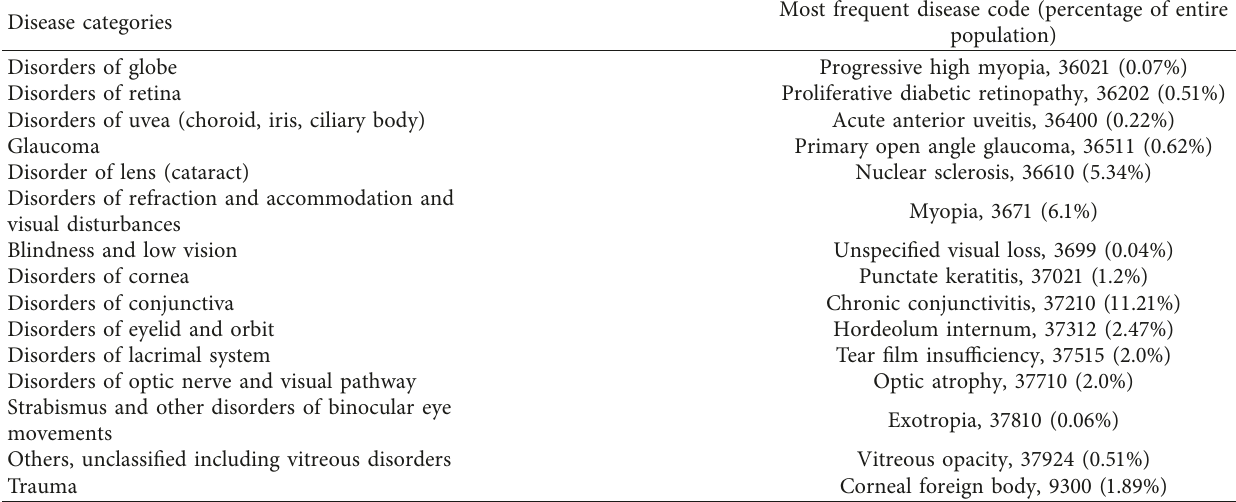
Table 3: Most frequent ICD-9-CM disease code in each